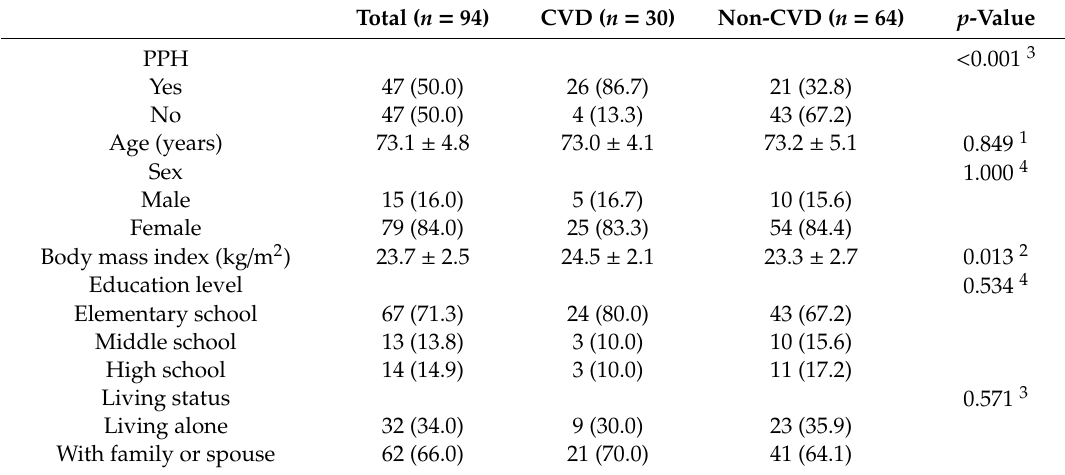
Table 2. Di ff erences of characteristics between participants who developed and did not develop new